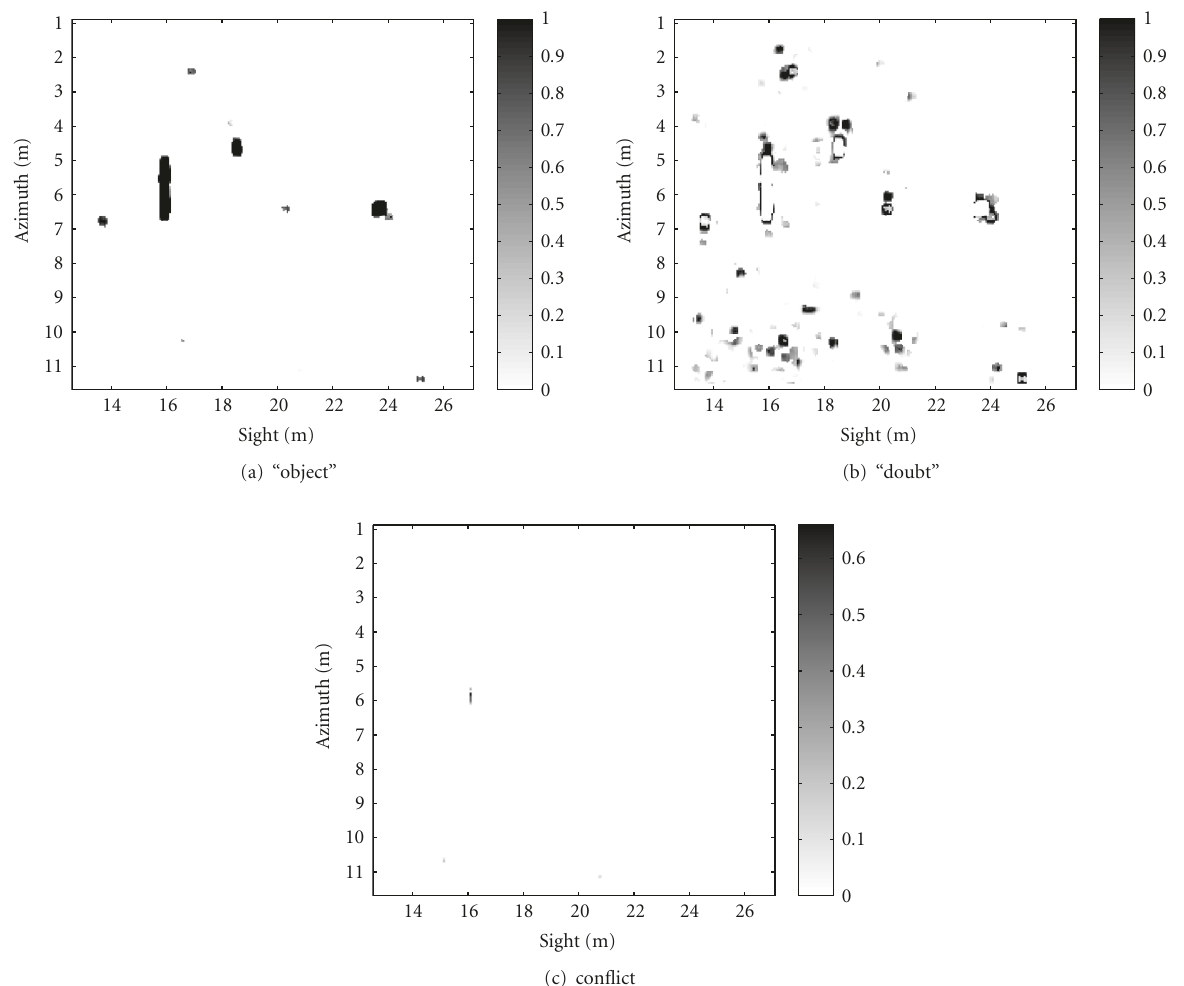
Figure 18: Mass images obtained for each proposition after the fusion of the mean standard deviation (segmentation) and kurtosis parameters in image 1.